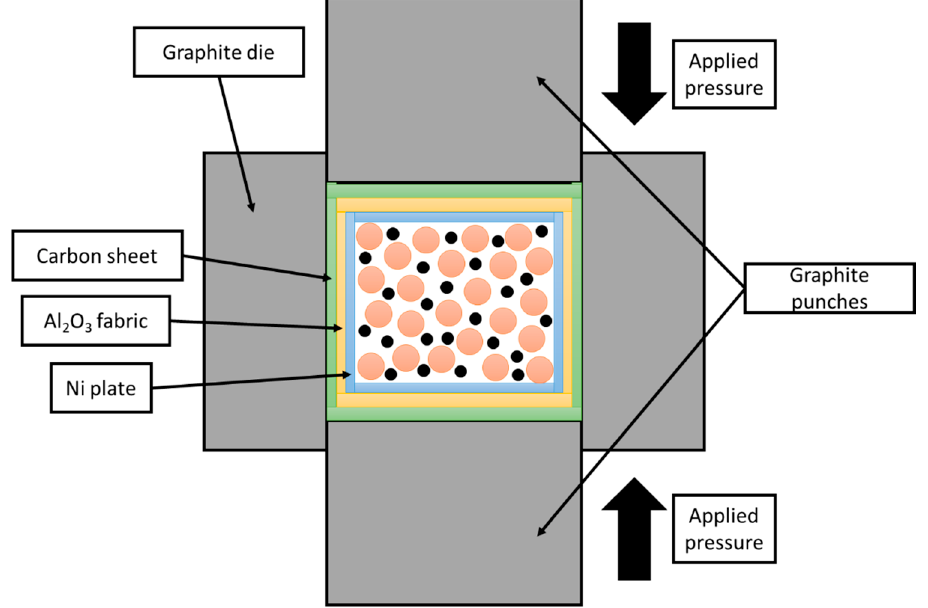
Figure 3. Sample emplacement for Spark Plasma Sintering.